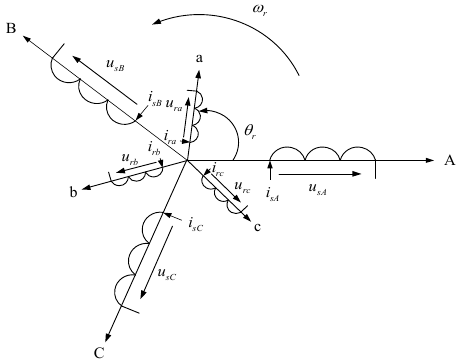
Figure 1. Equivalent physical model of the doubly fed induction generator. The voltage equation of stator three-phase circuit is shown in Equation (1) and the voltage equation of the rotor three-phase circuit is shown in Equation